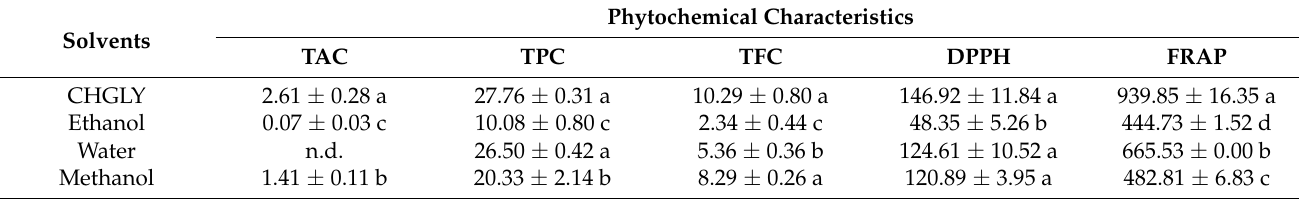
Table 1. Antioxidant properties of borage extracts obtained from different solvents.